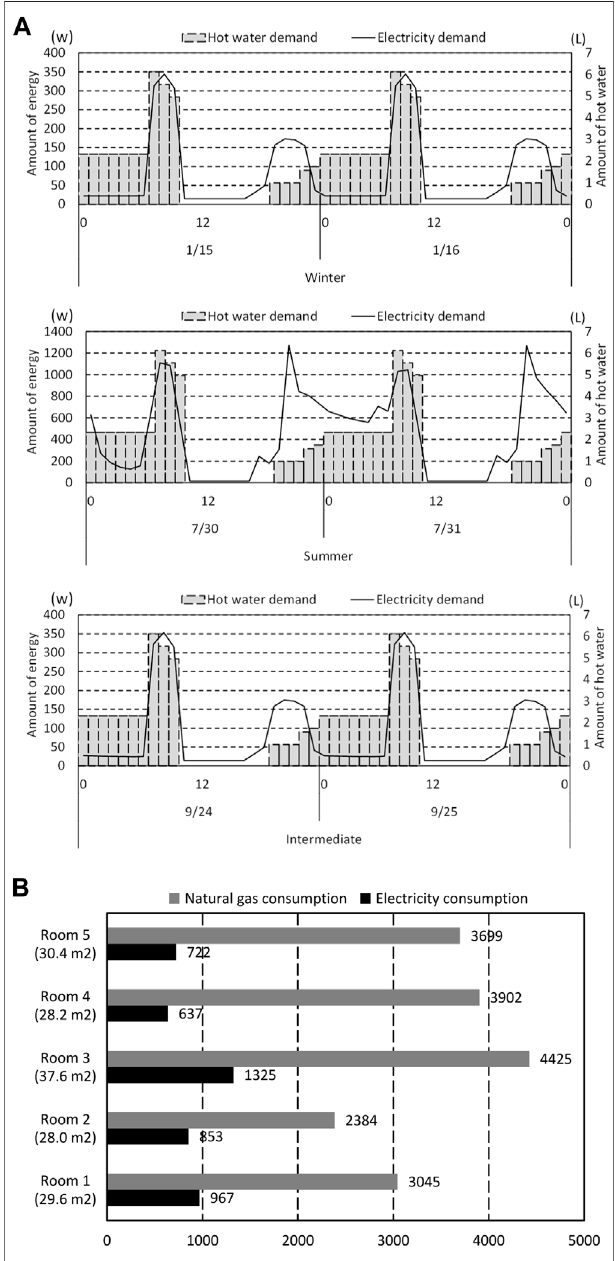
FIGURE 2 | Energy demand analysis of the small-scale apartments: (A) hourlyelectricityandhotwaterdemandofRoom1ontherepresentativedates in each season and (B) annual energy consumption for fi rst fl oor